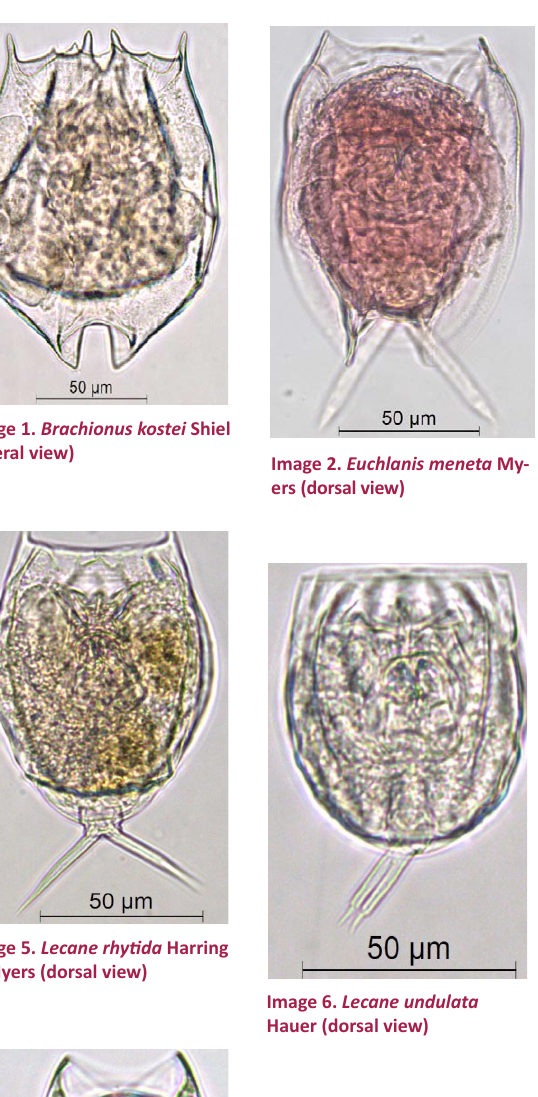
Image 5. Lecane rhytida Harring & Myers (dorsal view)